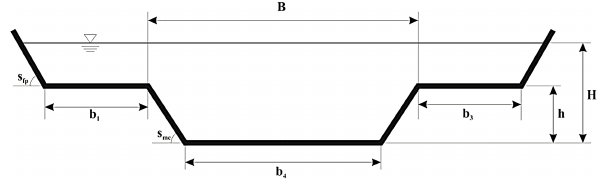
Figure 1. Geometric parameters of a compound channel. Table 1. Geometric and hydraulic laboratory parameters of the ex- periment